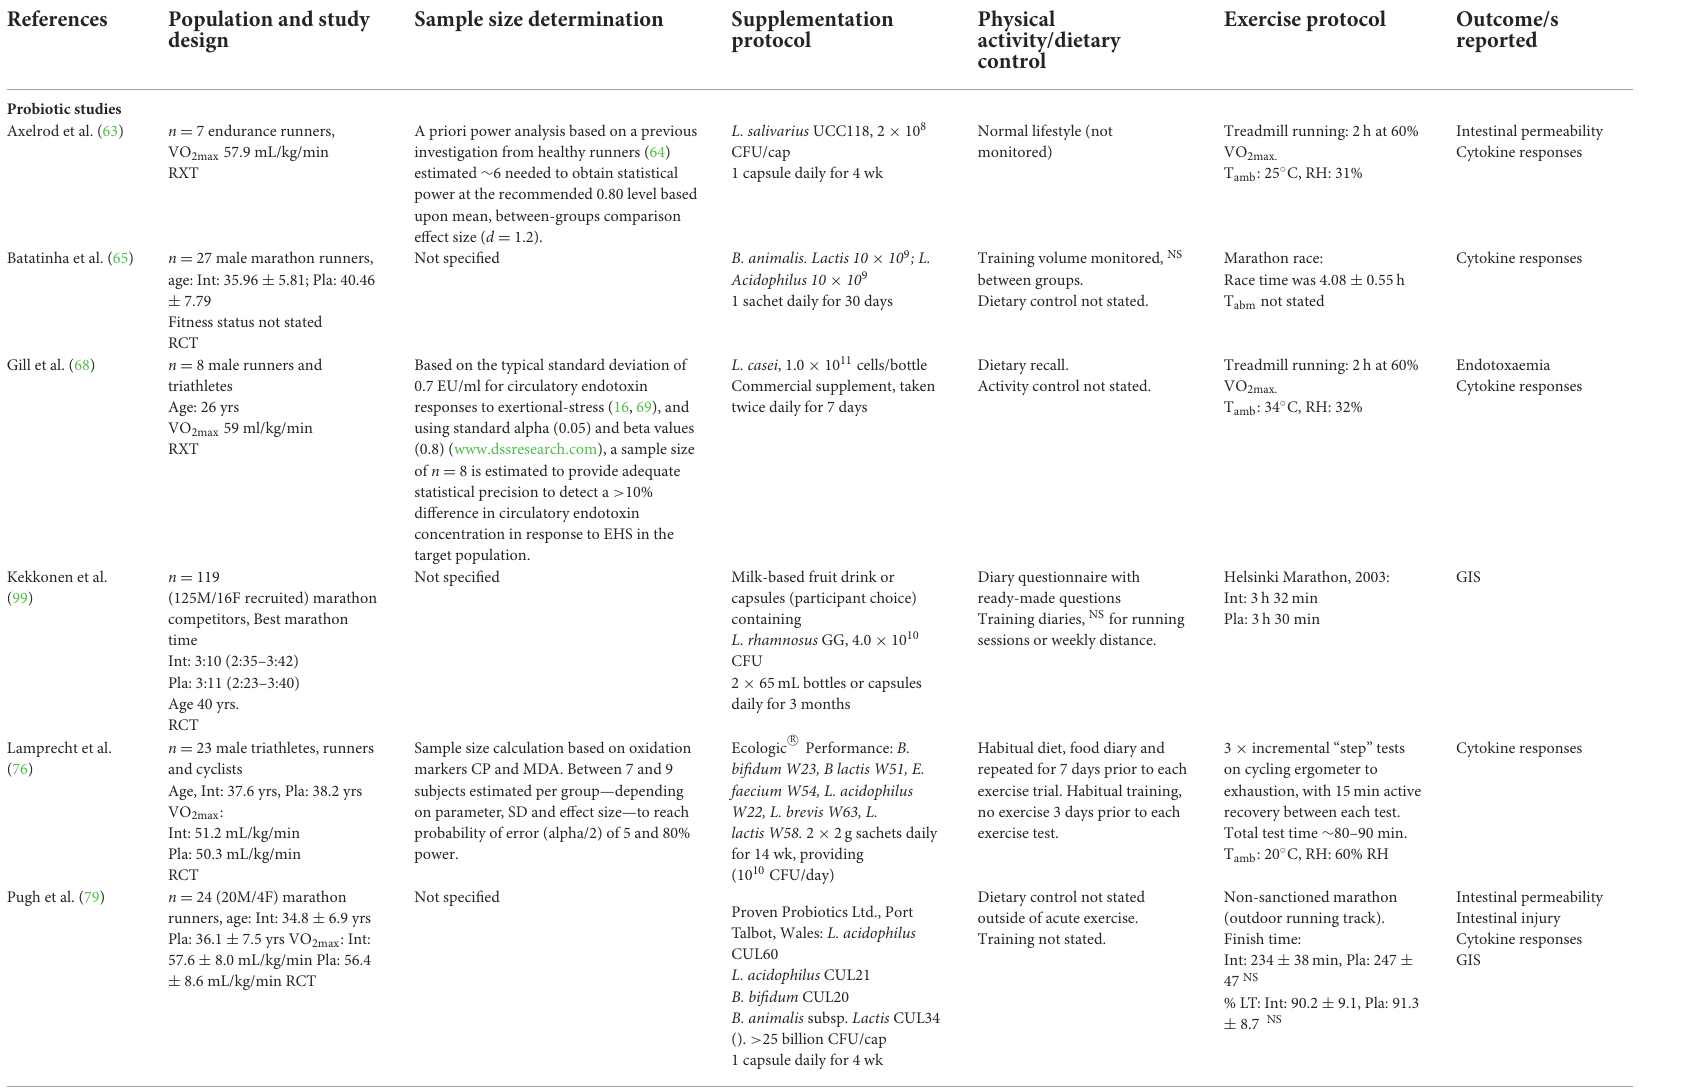
TABLE 5 Systematic review search results, included studies that investigated the impact of prebiotic, probiotic and synbiotic supplementation on markers of EIGS and associated GIS in response to an acute exercise